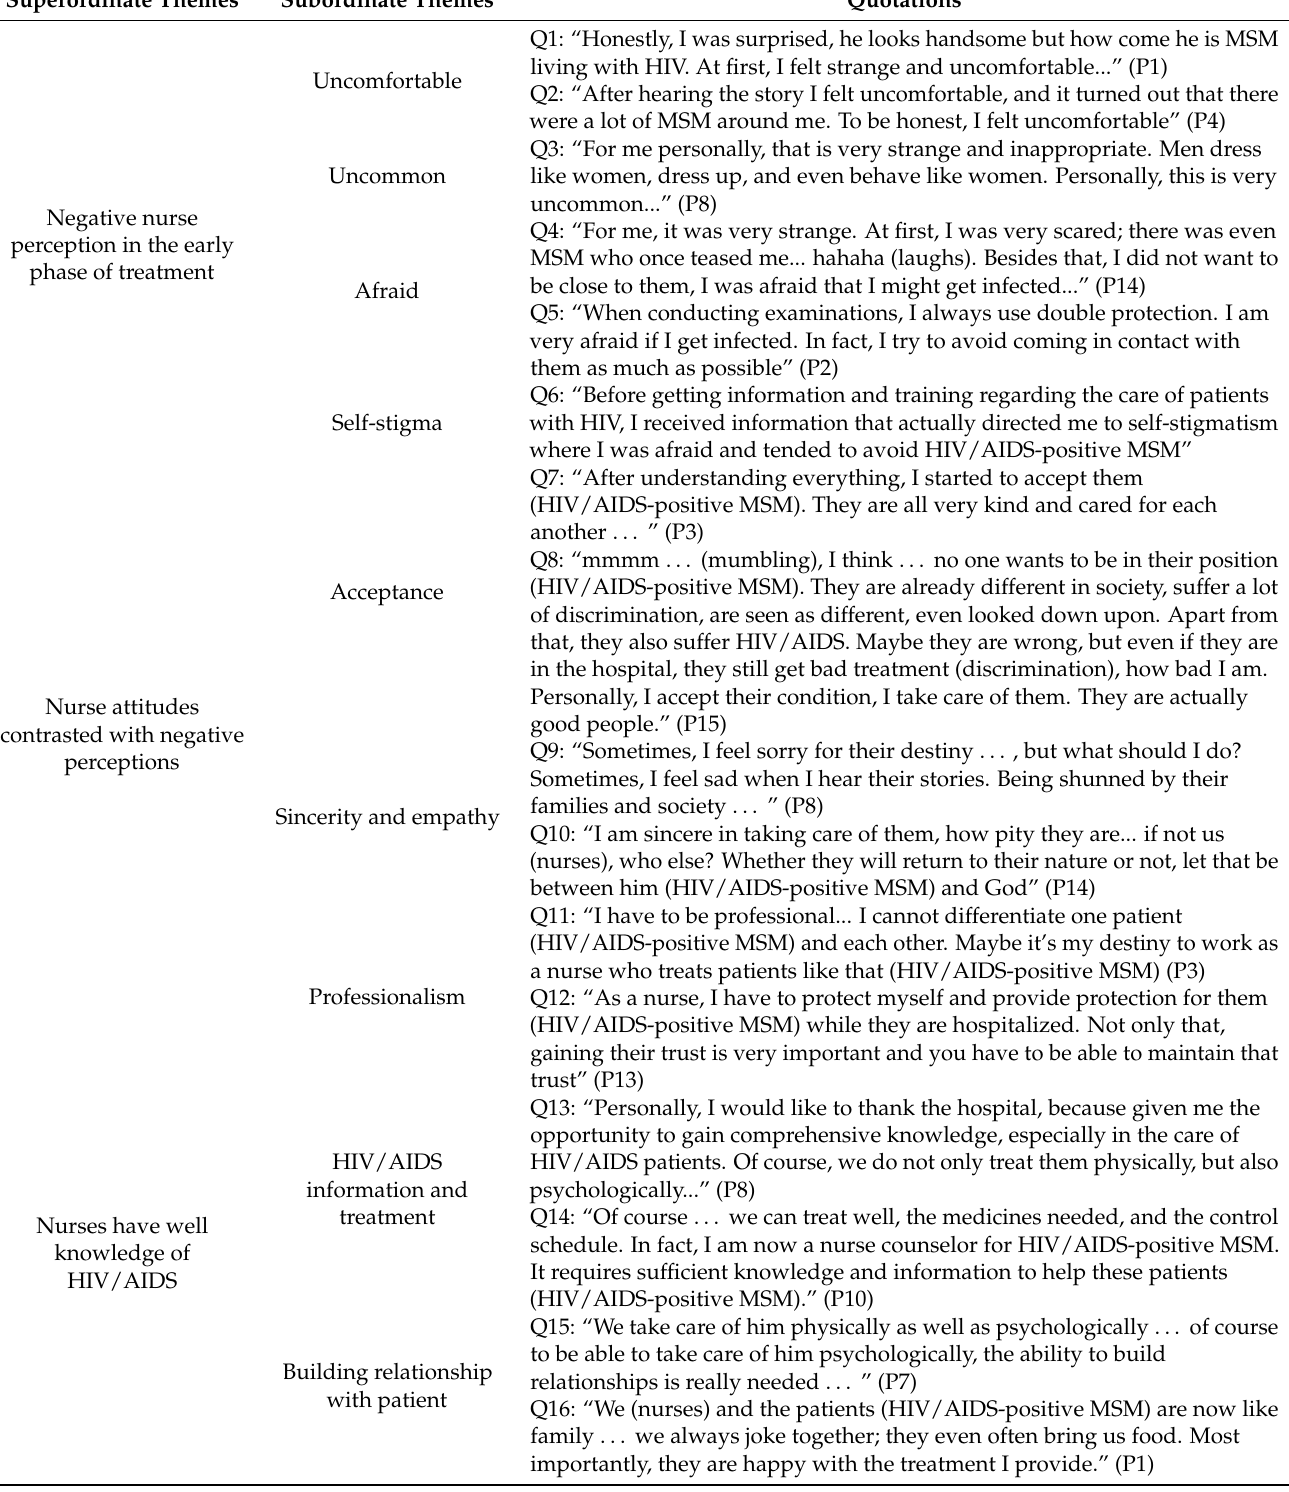
Table 2. Superordinate, subordinate themes, and participant